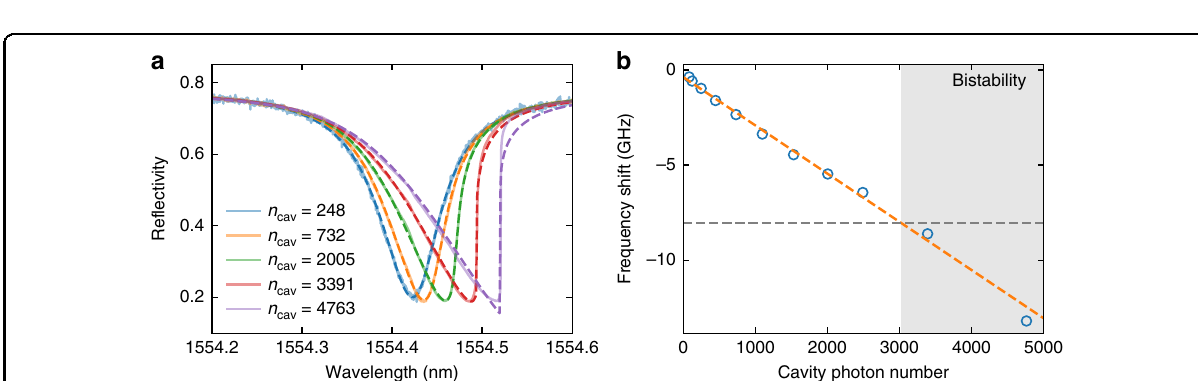
Fig. 4 Optical resonance frequency shift for different input power (converted to cavity photon numbers on resonance). a Re fl ection spectrum when sweeping the laser from short wavelength to long wavelength. Dashed lines are fi ts to extract the frequency shift, and the results are plotted in ( b ). A linear fi t is performed to extract the coef fi cient for the optical resonance tuning, which is used to obtain the bistability bound. The gray dashed line marks the maximal frequency shift above which optical bistability